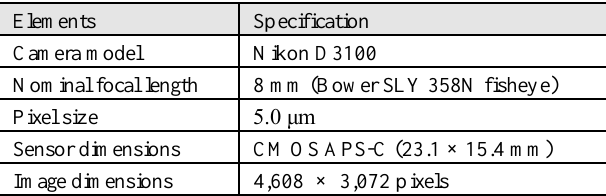
Table 1. Features of the fisheye camera.